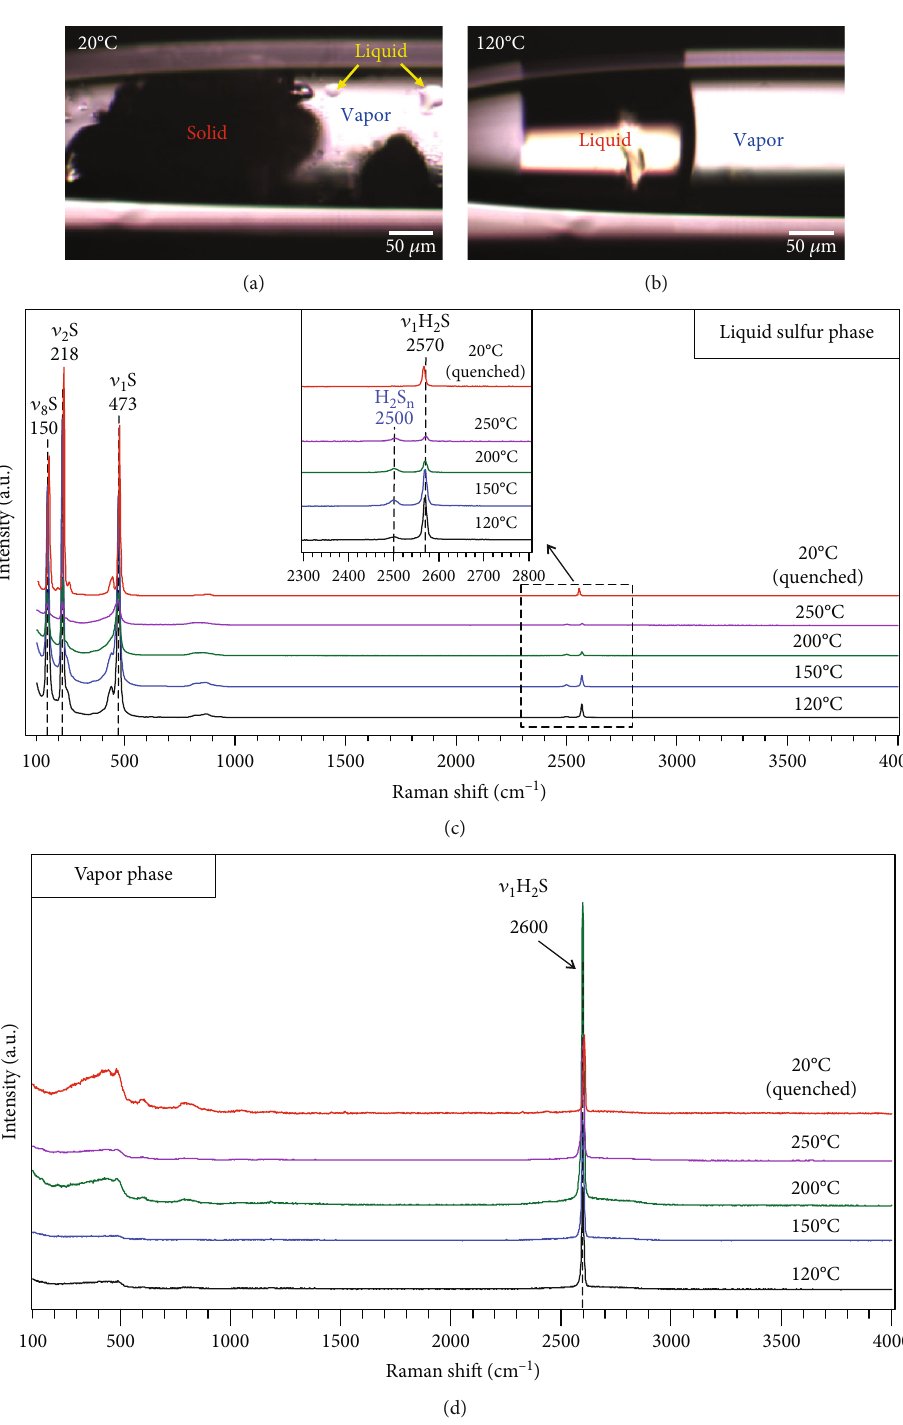
S system at 20 – 250 ° C. (a) Solid S, liquid H 2